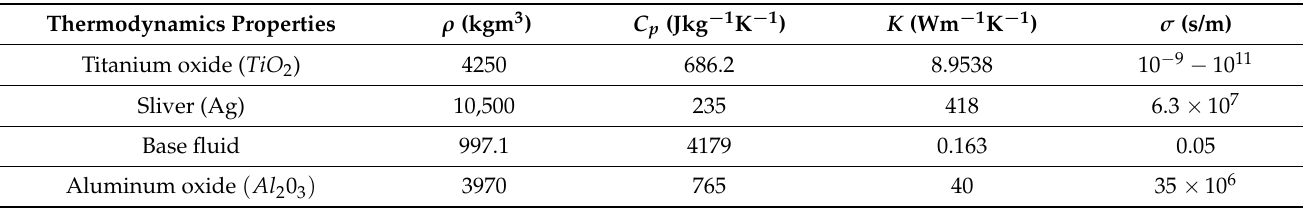
Table 1. Thermodynamics properties of